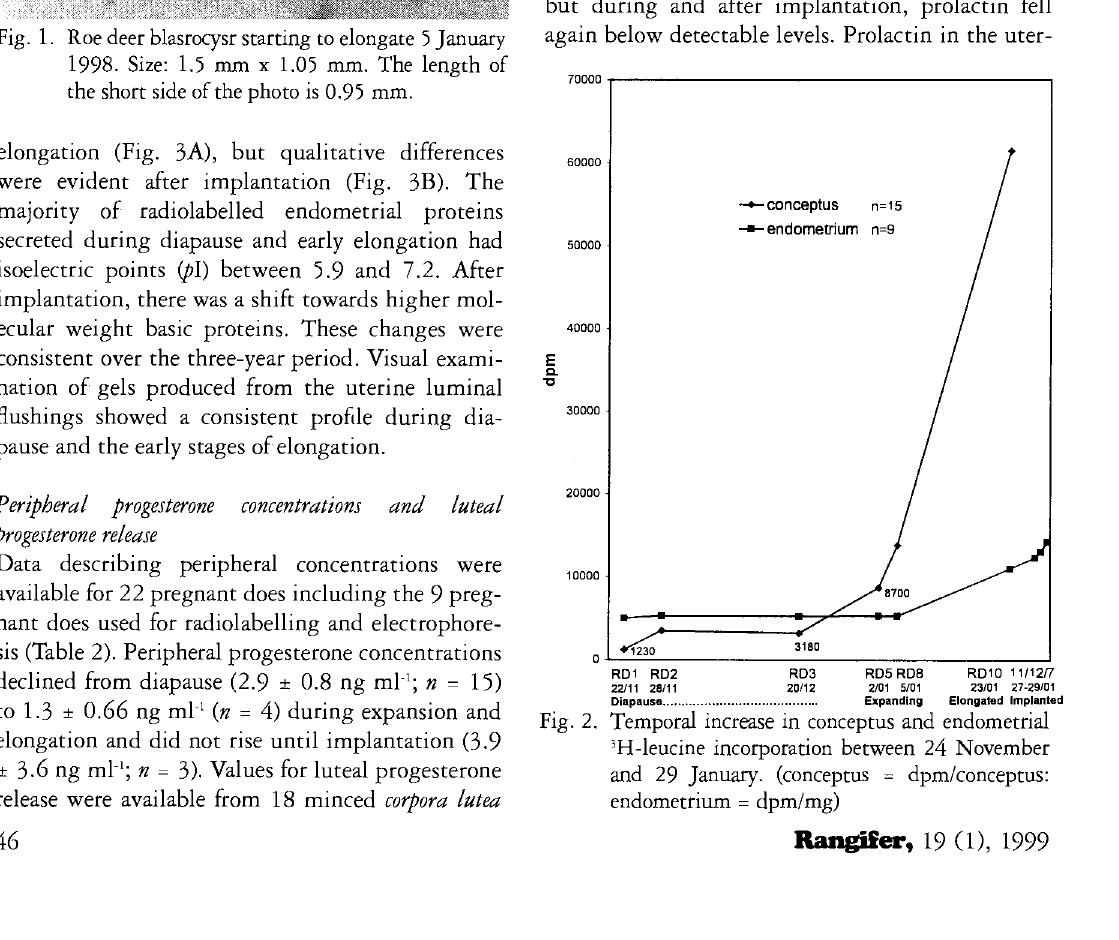
Fig. 1. Roe deer blasrocysr starting to elongate 5 January 1998. Size: 1.5 mm x 1.05 mm. The length of the short side of the photo is 0.95